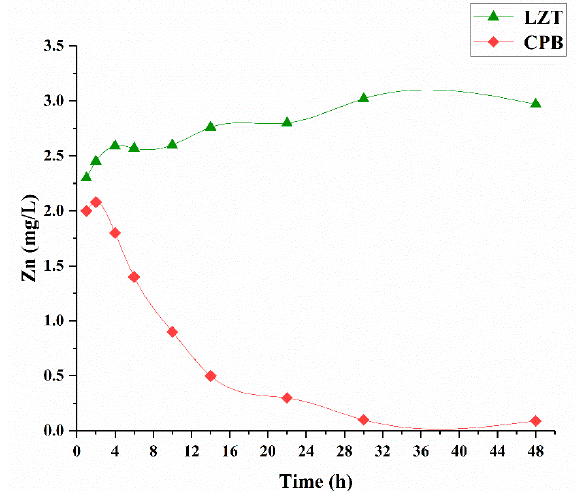
Figure 6. Zinc (Zn) concentration in static leachate of lead–zinc tailing (LZT) and backfill samples.